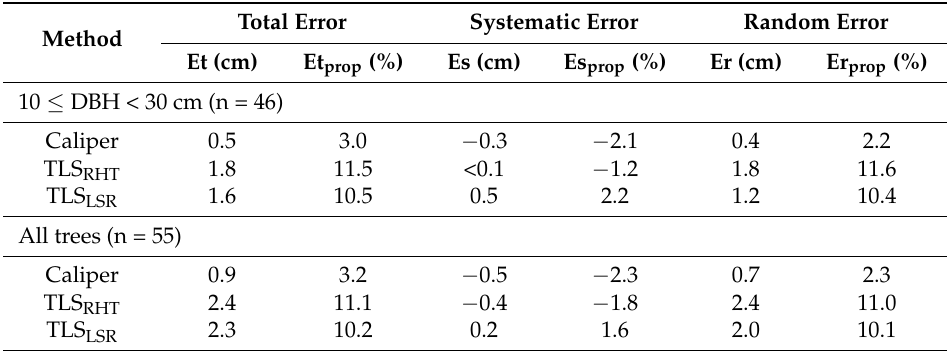
Table 1. A summary of the errors in estimated DBHs for different measurement methods relative to the observed (tape measure) DBHs for different size-classes of tropical trees: The errors are shown in absolute and proportional terms, respectively.